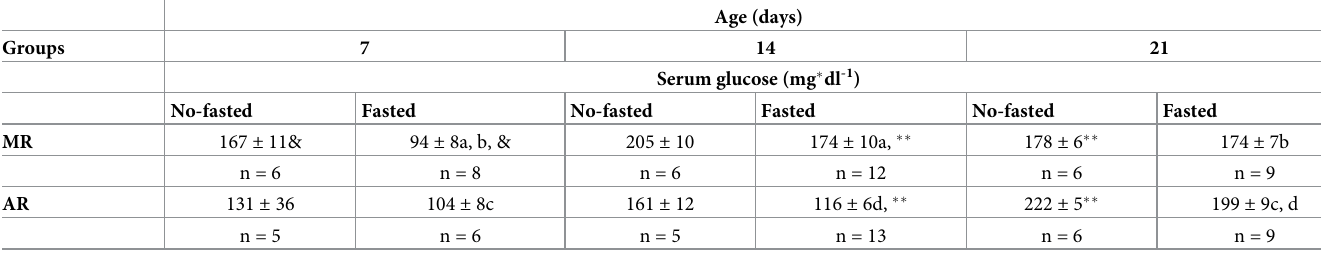
were the lowest compared with at pnd7 and pnd21, approximately 2.3 times less. In AR pups, the IGF-1 serum levels at pnd7 did not differ from those at pnd14, but at pnd21, the levels were 1.9 and 3.3 times higher than at pnd7 and pnd14, respectively. A substantial difference in the IGF-1 circulating levels between MR and AR pups was observed at pnd7, where the MR pups were 2 times higher than the AR pups. When we considered the differences in the serum IGF-1 levels observed in MR and AR rats, we looked for differences in bone growth. The increase in the body weight and tibia length in the two groups of animals were quite similar, Table 2. Serum glucose concentration in MR and AR pups, in a no-fasted or a fasted condition. Age (days) Groups 7 14 21 Serum glucose (mg � dl -1 ) No-fasted Fasted No-fasted Fasted No-fasted Fasted MR